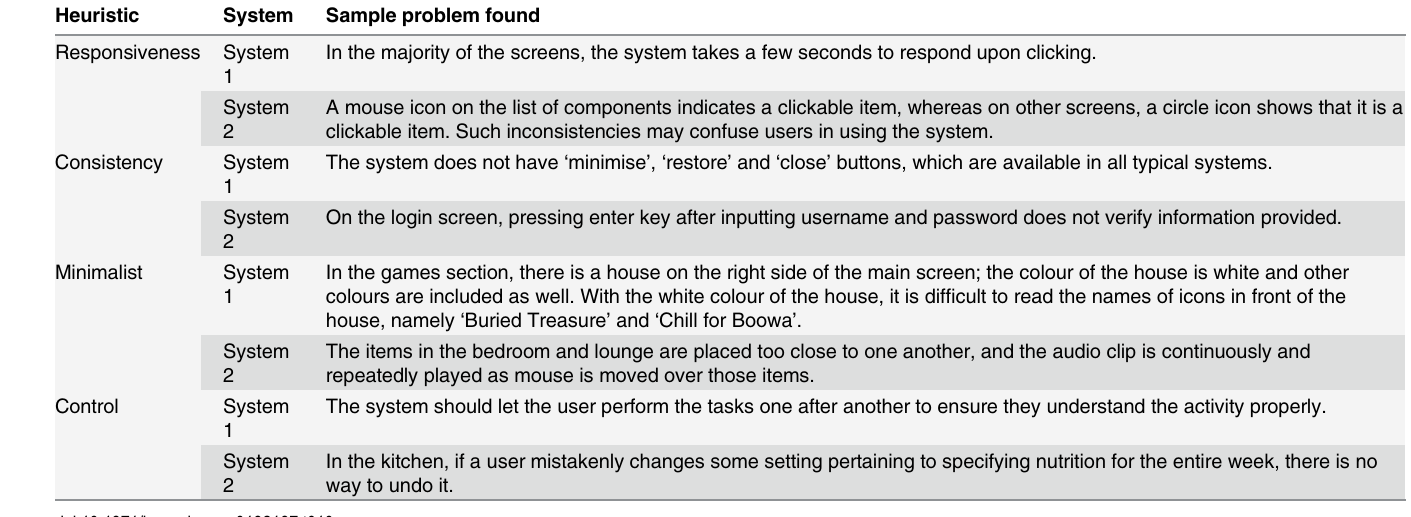
Table 10. Examples of problems found by frequently violated heuristics.